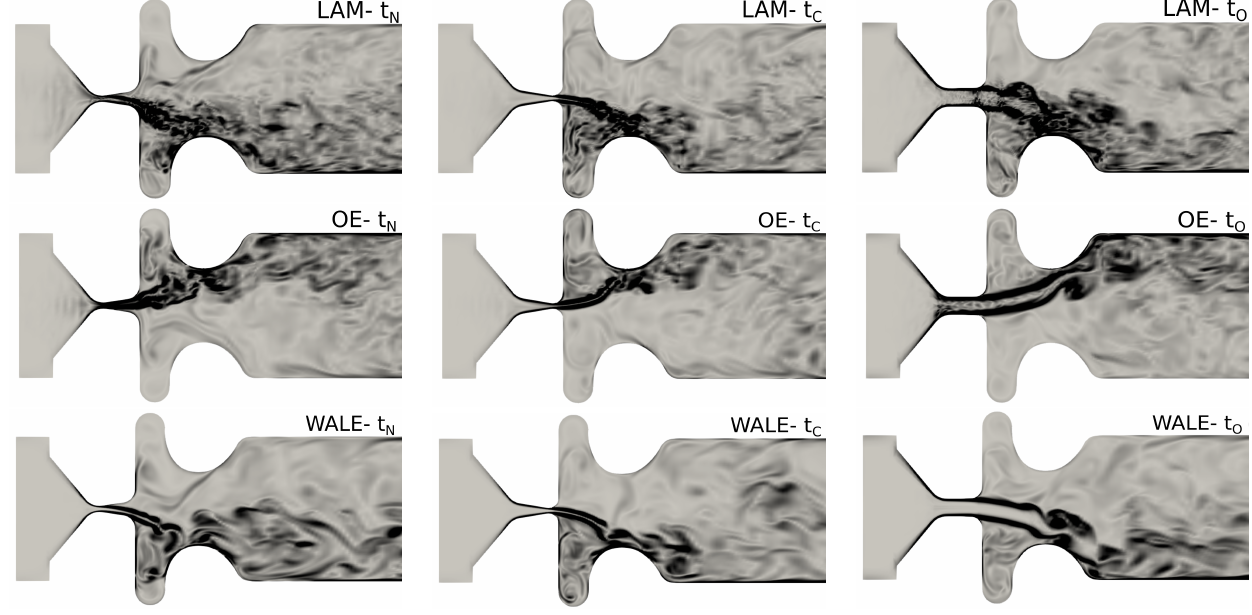
Figure 5. Vorticity fields | ω | in mid–coronal plane in range (0, 30,000) [s − 1 ].